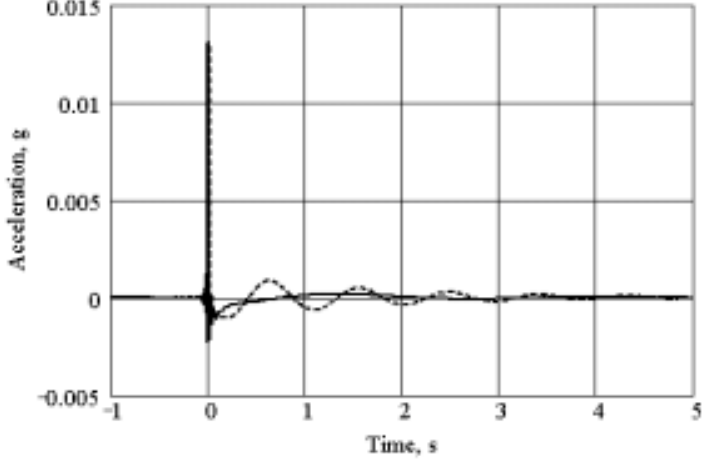
Fig. 12. Horizontal acceleration time history of the actively isolated workstation with add-on active dampers. Excitation by a short pulse. Dashed line – dampers off, solid line – dampers